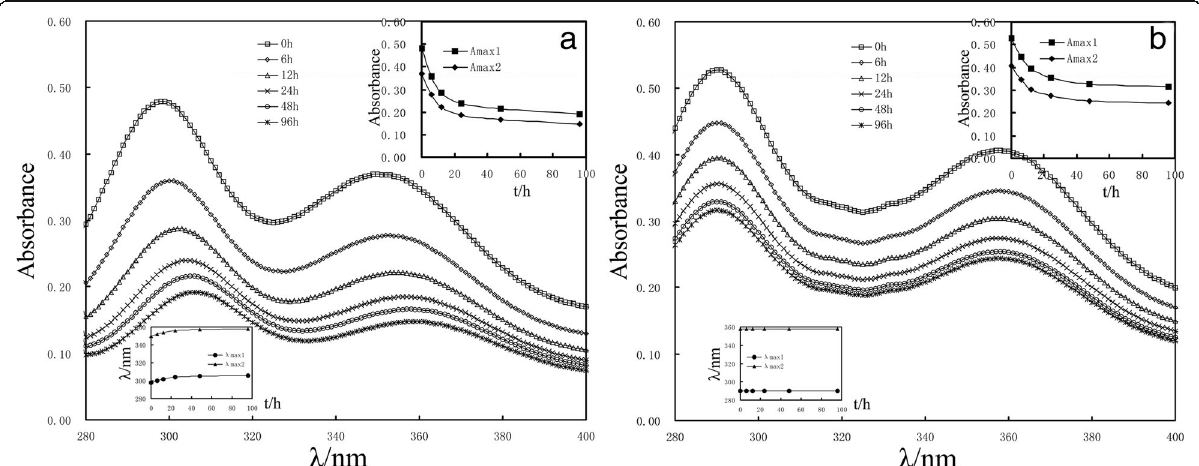
Fig. 1 UV absorbance changes with time of 1 mmol L − 1 cis -DIDP ( a ) and cisplatin ( b ) in deionized water. White square 0 h, white diamond 6 h, white up-pointing triangle 12 h, multiplication sign 24 h, white circle 48 h, asterisk 96